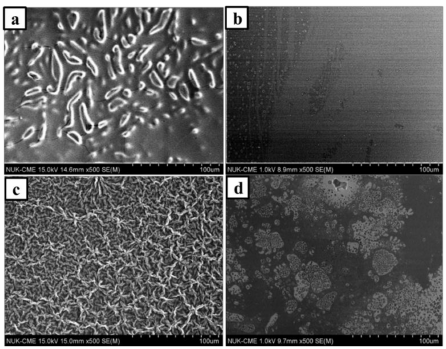
Figure 1. Scanning electron microscopy (SEM) images of ( a ) polymer ionic liquid (PIL)-(Br); ( b ) PIL-M-(Br); ( c ) PIL-(TFSI); and ( d ) PIL-M- (TFSI) films.